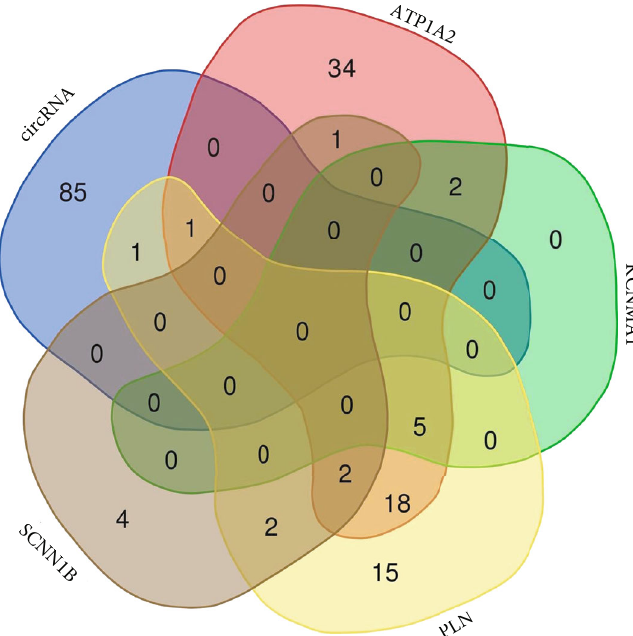
Figure 7: The intersection of miRNA. ATP1A2 had 63 targeted miRNA, PLN had 44 targeted miRNA, KCNMA1 had 7 targeted miRNA, and SCNN1B had 9 targeted miRNA. circRNA identi fi ed 87